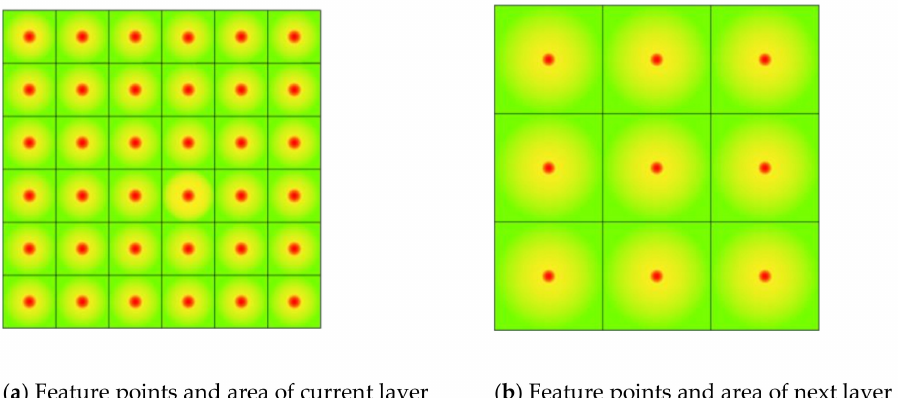
Figure 8. Feature points and feature